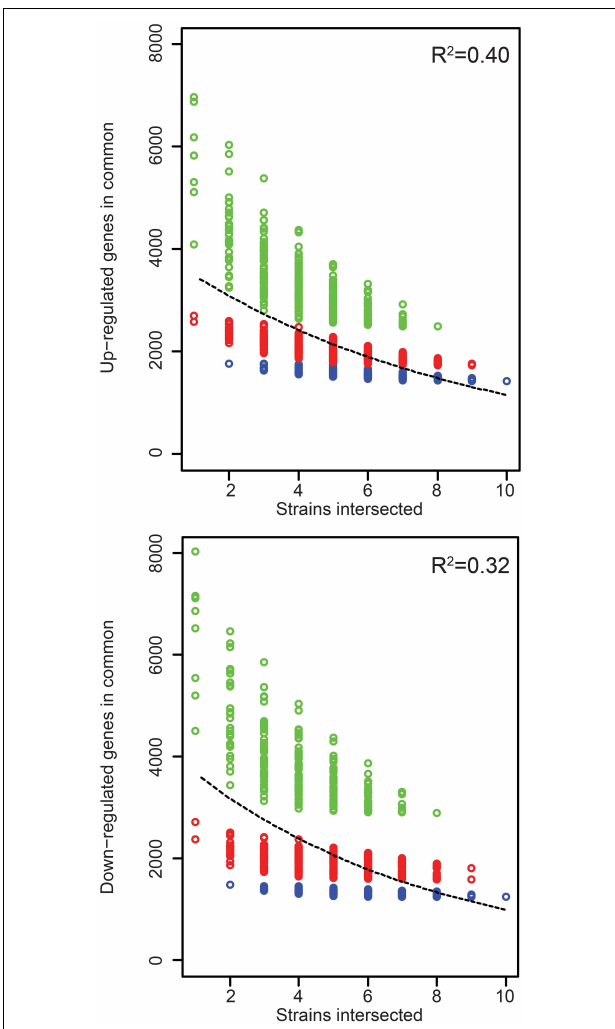
FIGURE 3 | Rice gene expression changes induced in common by the Xoc strains. The number of genes up- or down- regulated in rice (cv. Nipponbare, at 48h after syringe infiltration) in common by each of n strains across all possible groups of strains is plotted as a function of n . The least-square fit of an exponential decay function is shown as a dashed line, with R 2 values for the fit displayed in the upper-right of each graph. CFBP2286 and BXOR1 induced the fewest gene expression changes (up or down), and this is reflected in stratification of the points in each plot. To make this apparent, groups containing only one of these strains are shown in red and groups containing both in